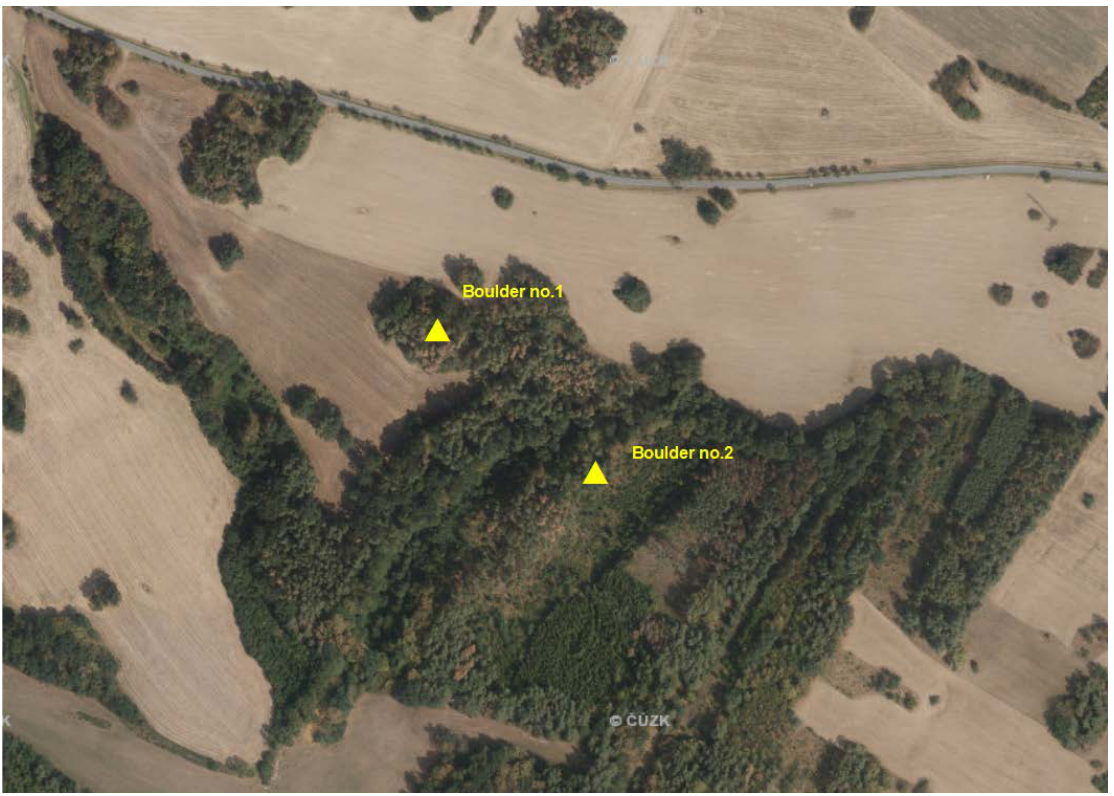
Figure 2. Localization of boulders.